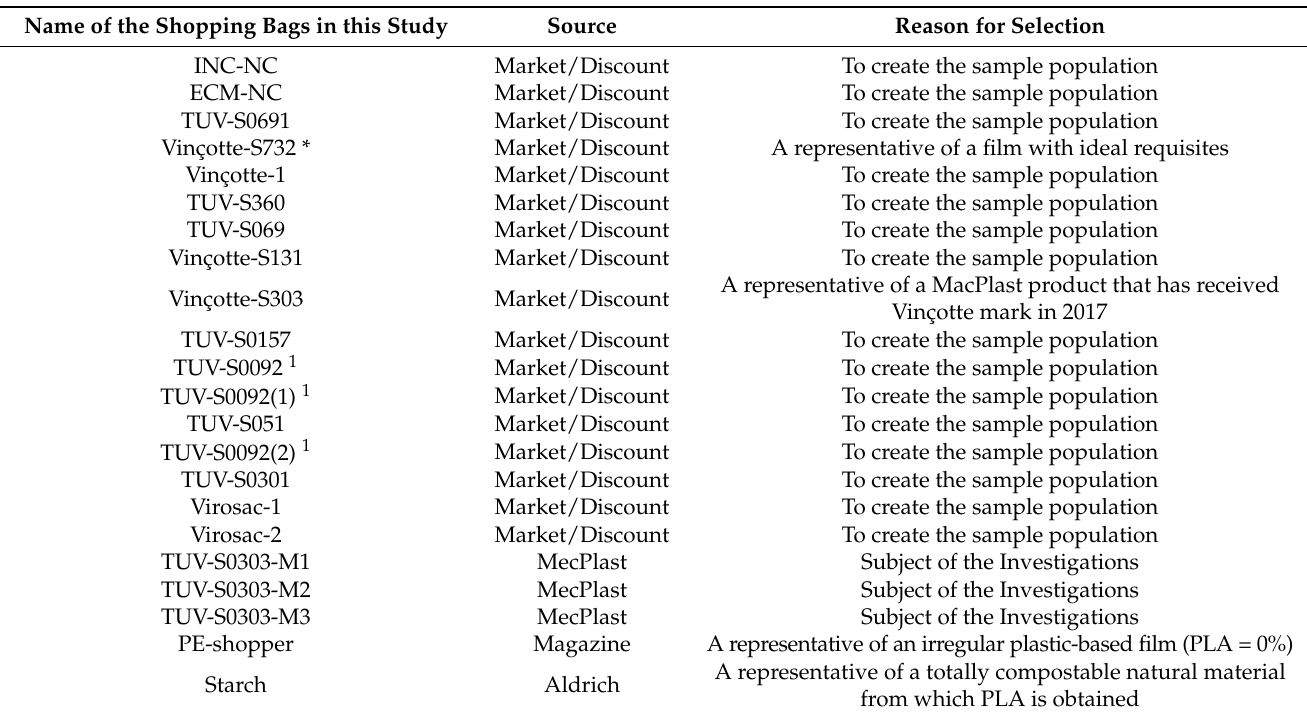
Table 2. Names of the samples in this study, their origin, and the reasons for why they were included in the samples